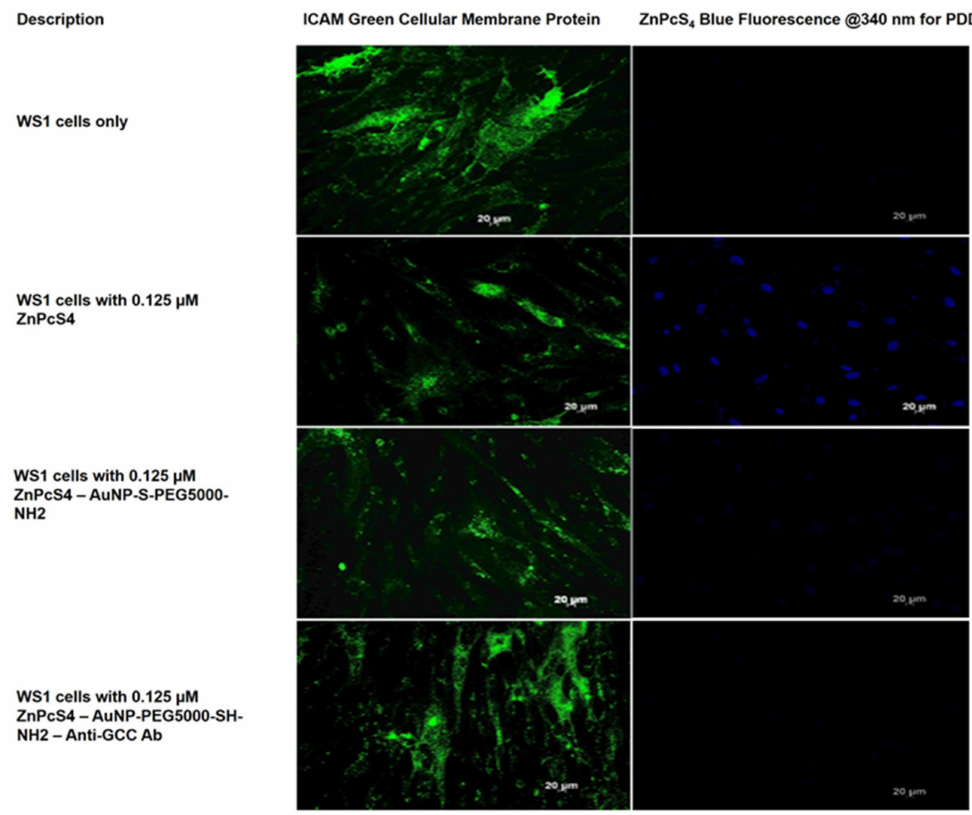
Figure 8. PDD images comparison of ZnPcS 4 PS uptake in WS1 cells, treated with ZnPcS 4 PS alone, AuNP-S-PEG5000-NH 2 - ZnPcS 4, and the final BNC. Cellular ICAM membrane proteins (green), and ZnPcS 4 PS localization